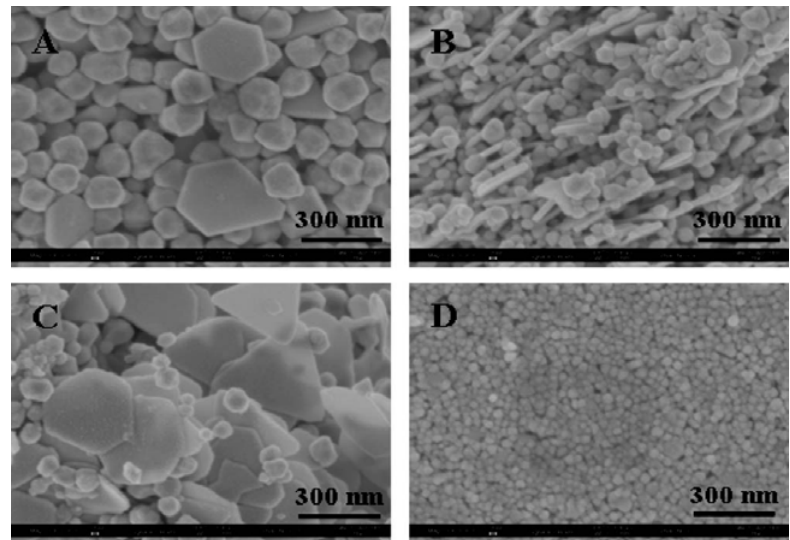
Fig. 5. SEM images of the gold nanoparticles formed by the reaction of 1 mM HAuCl4 and 5% Diopyros kaki leaf broth at different reaction temperatures: (A) 25 o C, (B) and (C) 60 o C, and (D) 95 o C.